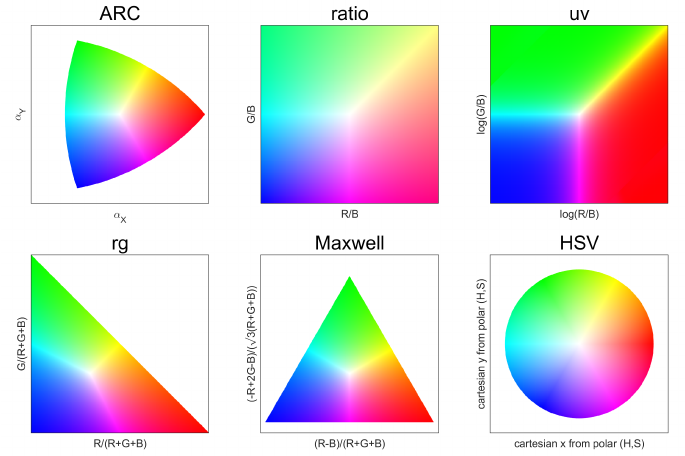
Figure 5. RGB gamut as displayed in different chromaticity